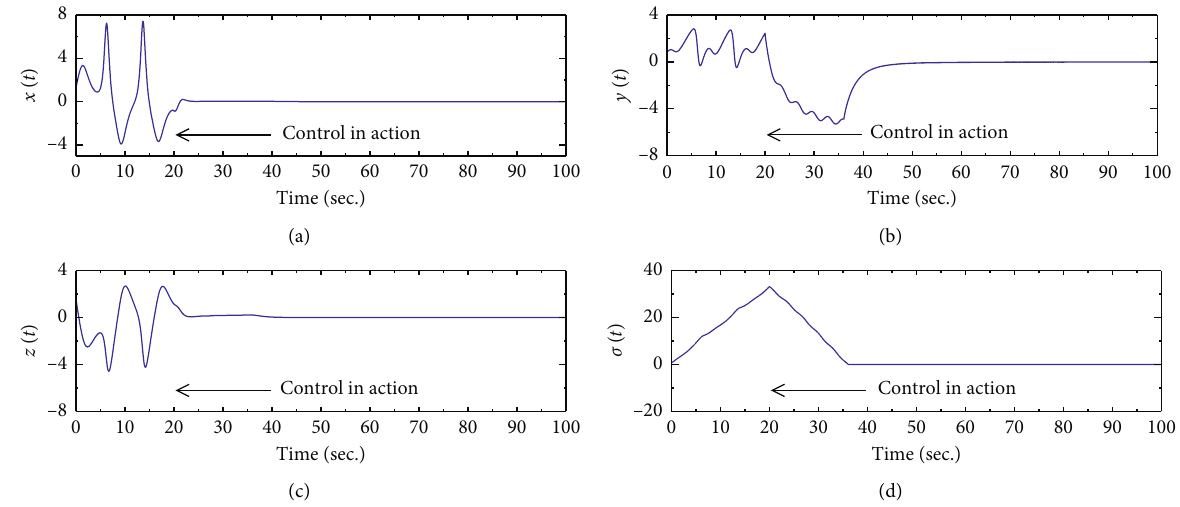
Figure 13: The time series of the controlled incommensurate fractional-order system state variables and corresponding time series of the sliding surface with uncertainty and external disturbance (the control input is activated at t � 20 sec).